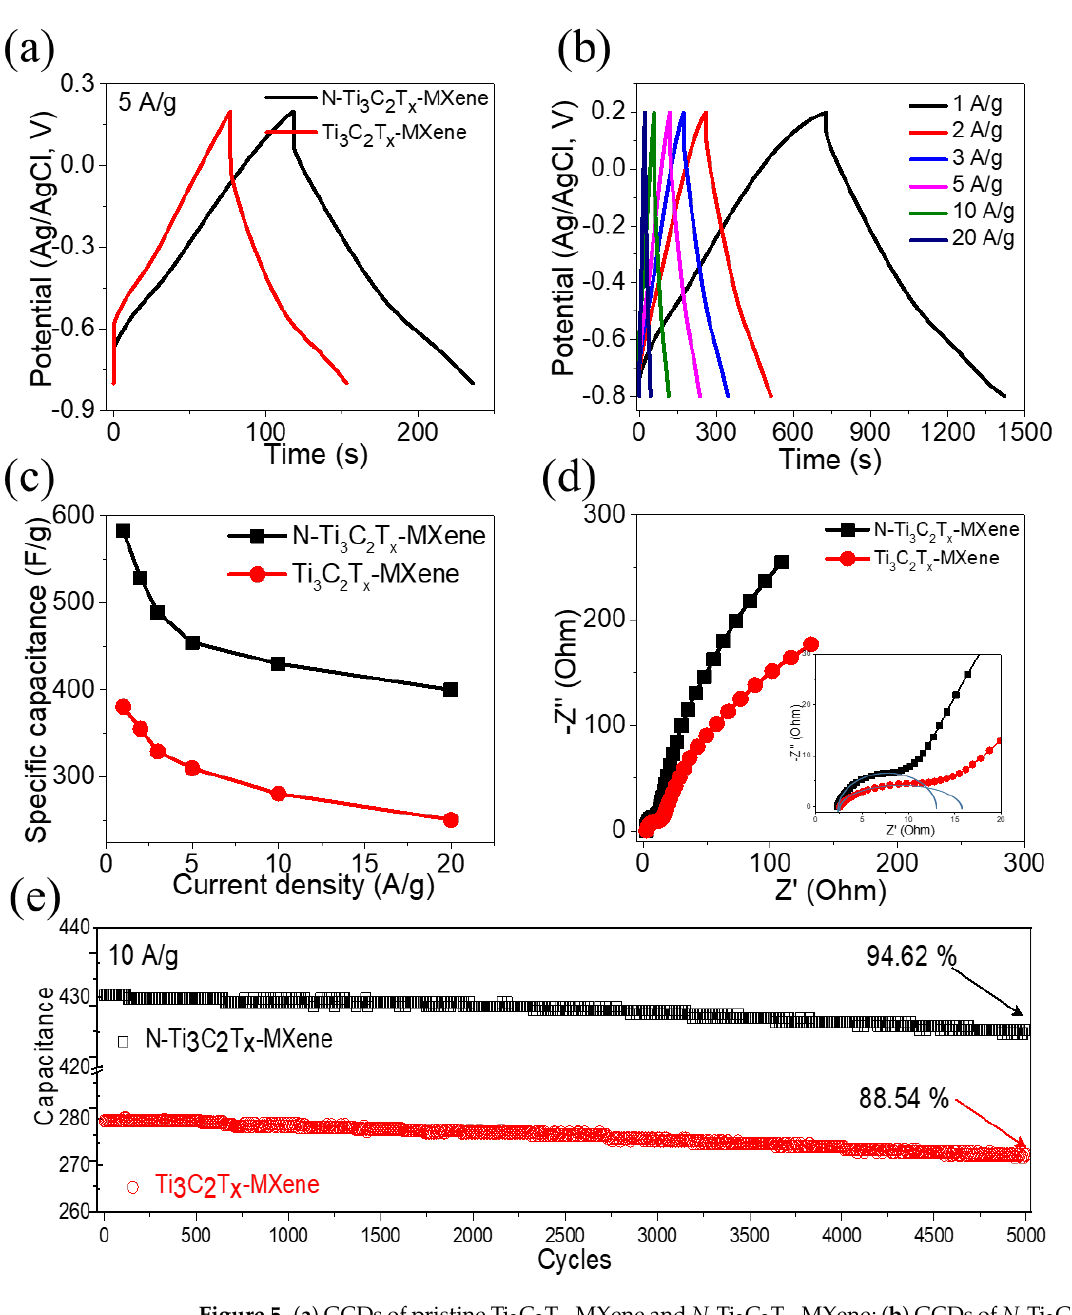
Figure 5. ( a ) GCDs of pristine Ti 3 C 2 T x -MXene and N -Ti 3 C 2 T x -MXene; ( b ) GCDs of N -Ti 3 C 2 T x -MXene at different current densities; ( c ) specific capacitance of pristine Ti 3 C 2 T x -MXene and N -Ti 3 C 2 T x - MXene versus current density; ( d ) Nyquist plots; and ( e ) cyclic